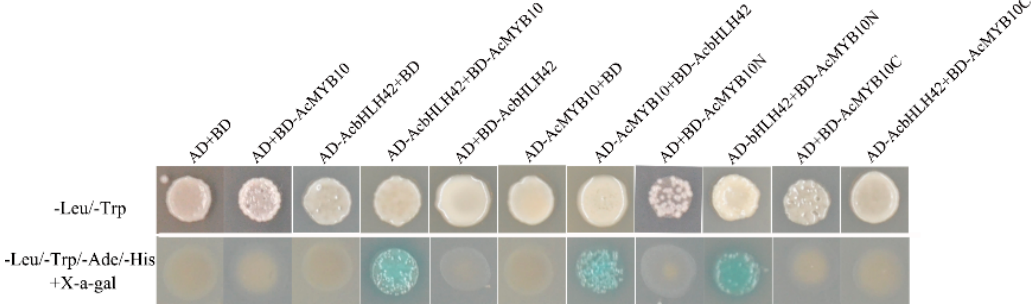
Figure 8. Interactions between AcMYB10 and AcbHLH42 detected by the yeast two-hybrid assay. AH109 yeast cells containing plasmids were grown on double-and quadruple-selection media. The X- α -gal assay was performed to confirm positive interactions.